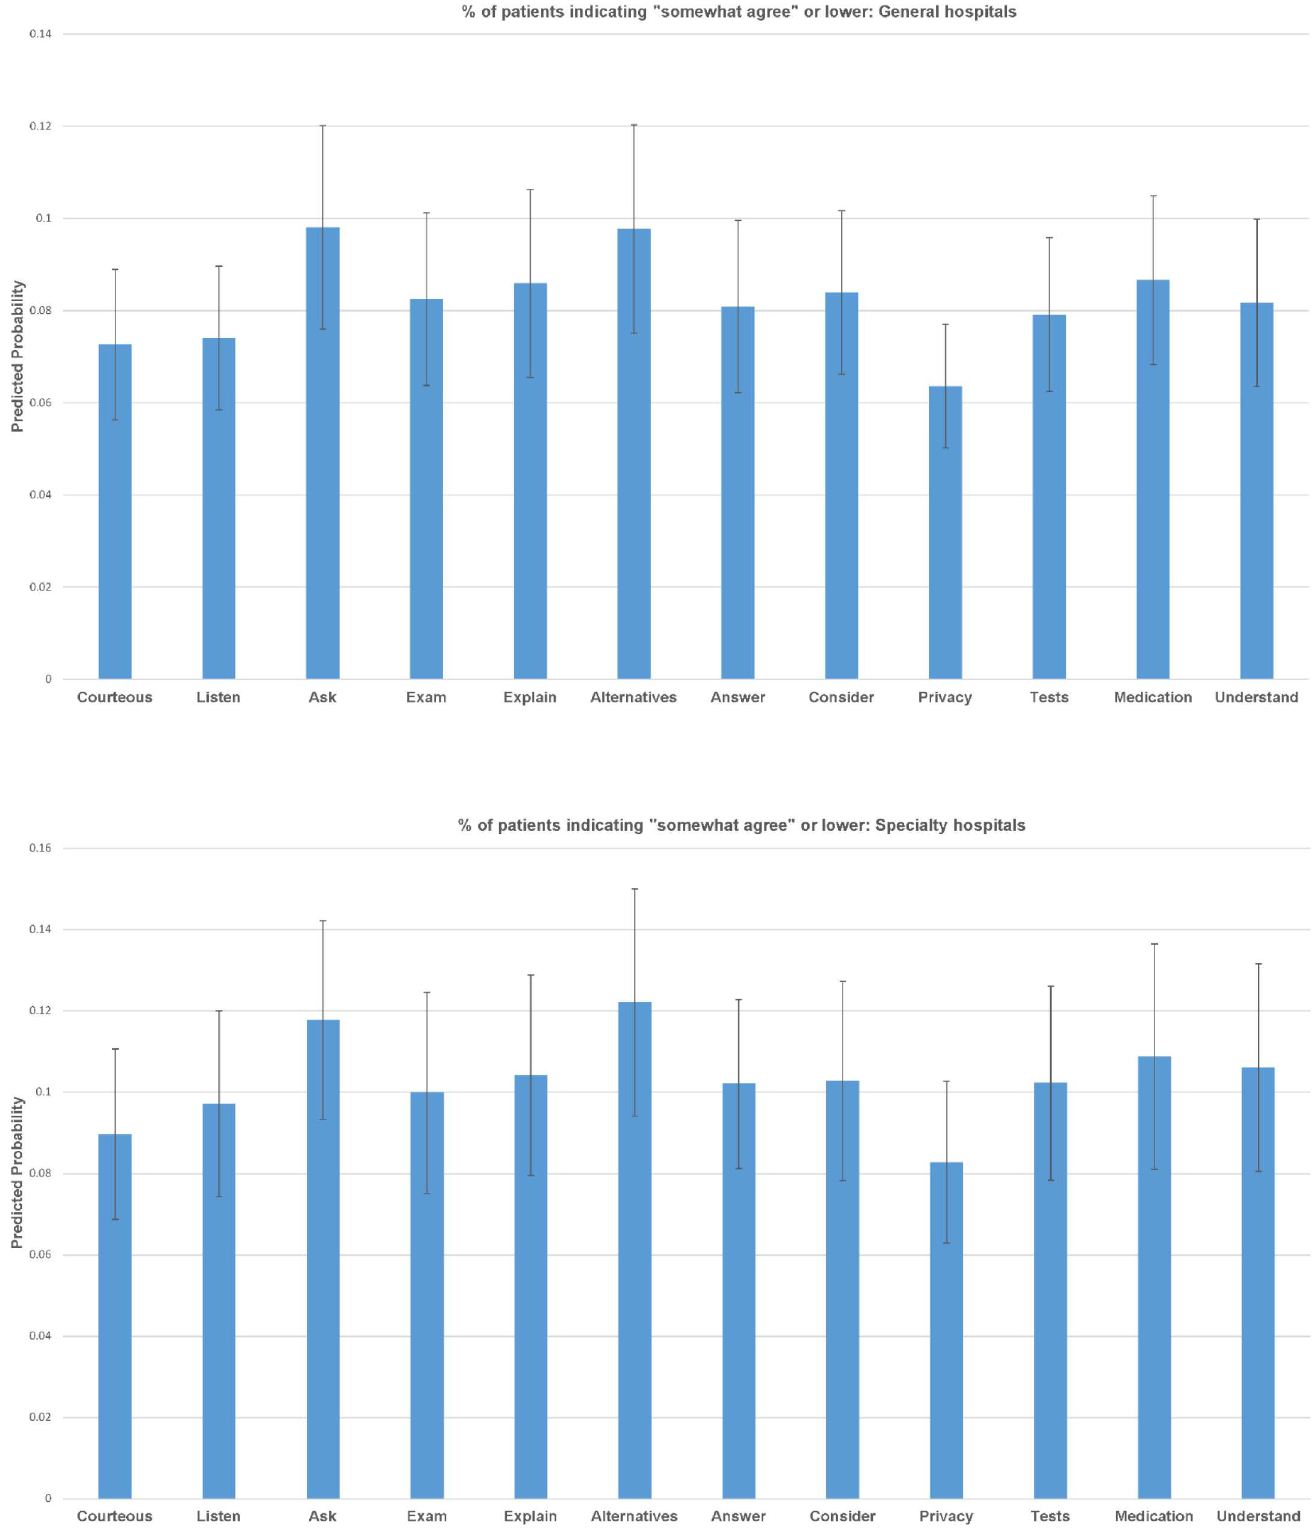
Fig 1. % of patients indicating “somewhat agree” or lower. (A) Generalhospitals.(B) Specialty hospitals.